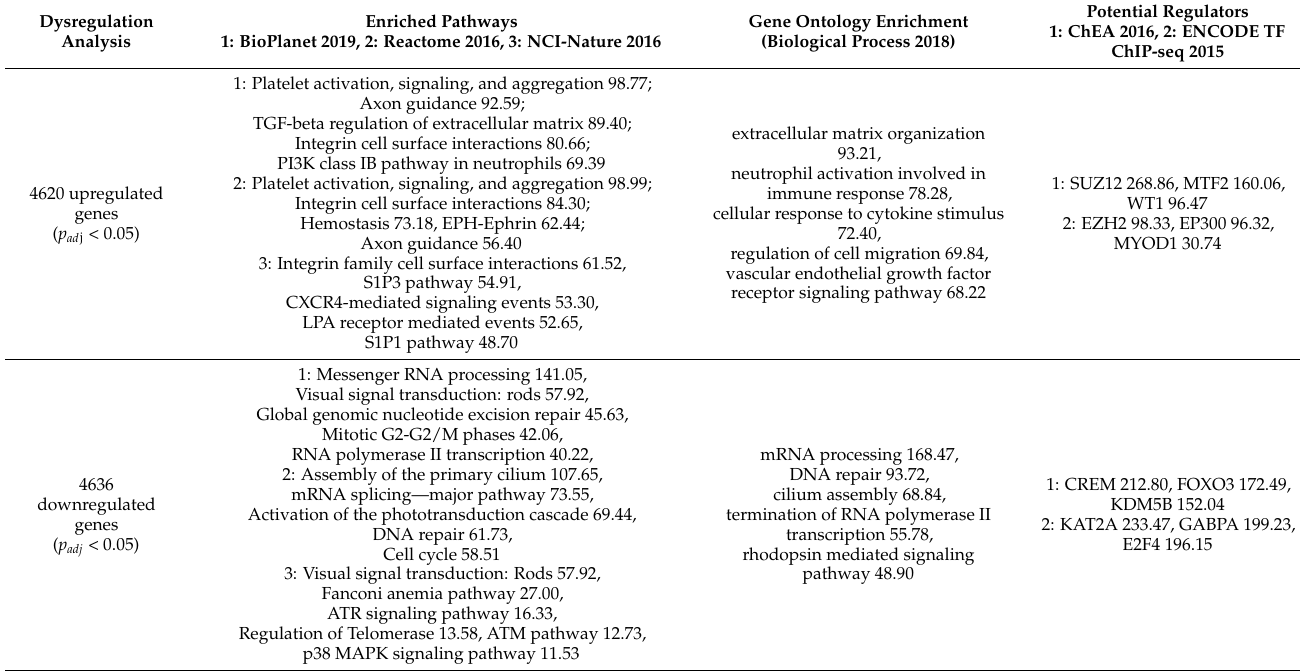
Table 1. Enrichment analysis for dysregulated genes derived from the VPP RNAseq analysis. Enriched pathways and potential upstream regulators were predicted using the indicated databases. For gene ontology enrichment, only the top five non-redundant significantly enriched biological process terms are shown. The numbers following the terms are the combined score as calculated by Enrichr. Only terms with a combined score >5 were